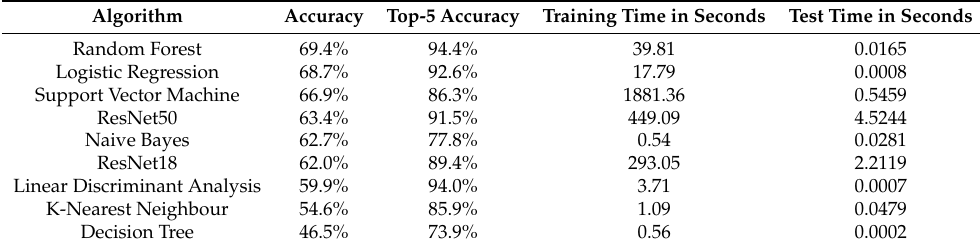
Table 2. Accuracy, top-5 accuracy, training and test time of the most accurate classifier for each machine-learning algorithm. Random Forest was the most accurate algorithm. Support Vector Machine required a significantly longer training and test time than the other algorithms. It should be noted that unlike the other algorithms, the ResNets were trained and tested on a Graphics Processing Unit (GPU) instead of a Central Processing Unit (CPU).